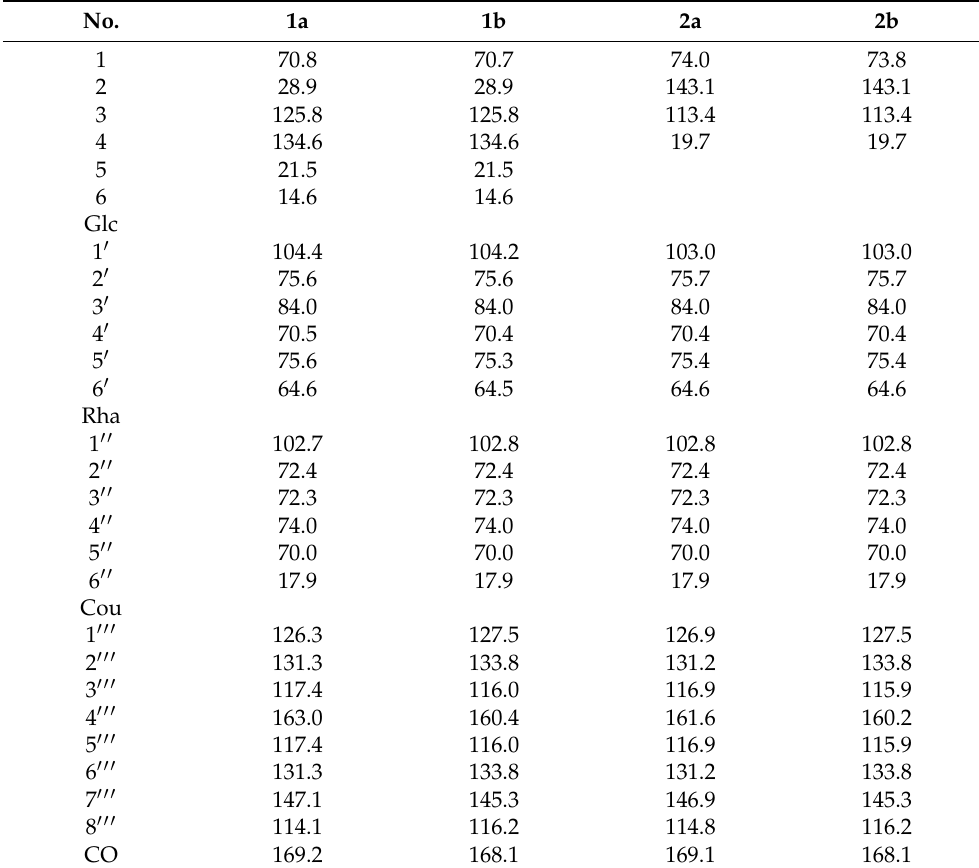
Table 2. 13 C NMR (150 MHz) data of compounds 1 – 2 from L. robustum in CD 3